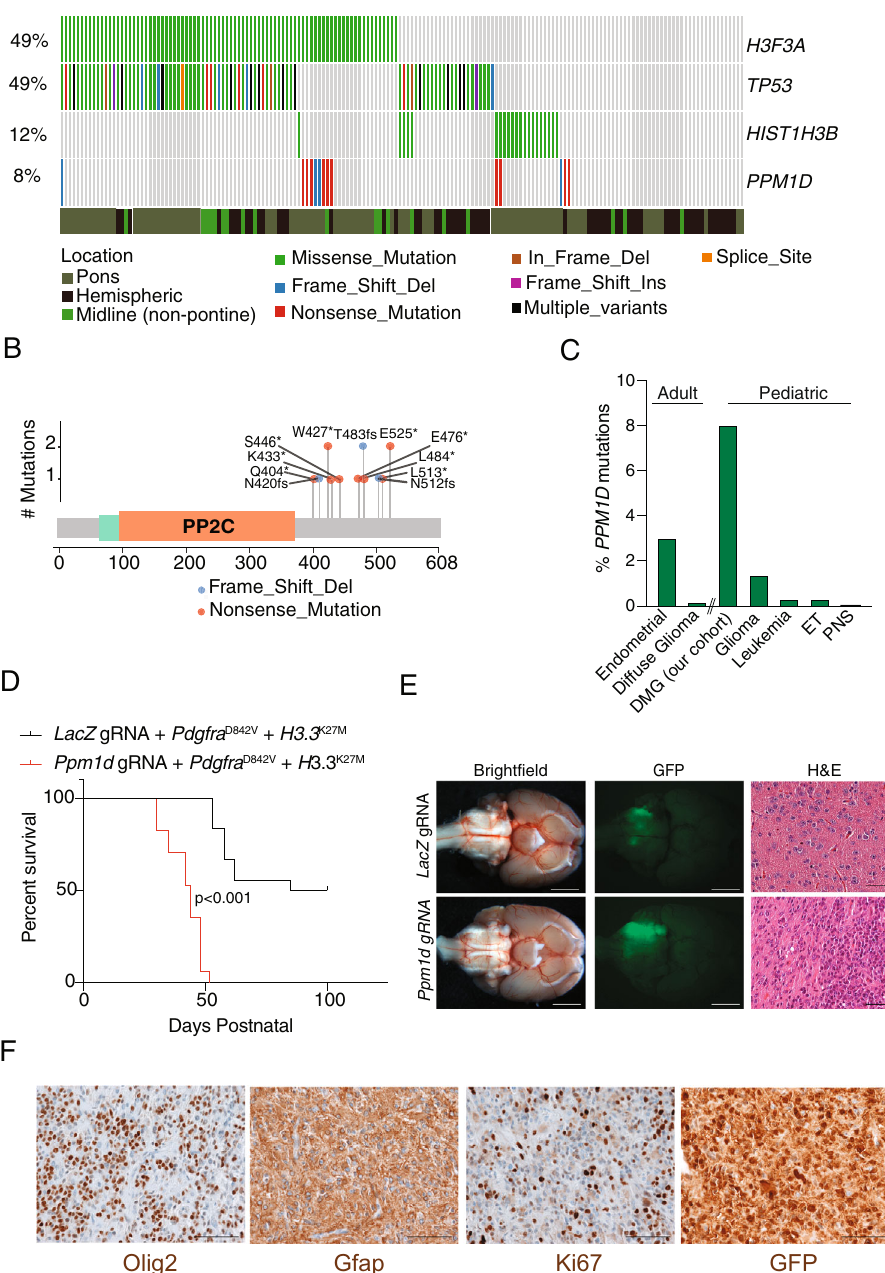
Fig. 1 PPM1D mutations are oncogenic drivers of DMGs. A Comutation plot showing alterations in histones ( H3F3A and HIST1H3B ), TP53, and PPM1D in 170 midline and non-midline gliomas. Variants observed are depicted below. B Lollipop plot of recurrent C-terminus PPM1D truncating mutations observed in DMGs. The position of nucleotide variants are shown. *Depicts nonsense or truncating alterations. C Percentage of samples with PPM1D truncating mutations across different adult and pediatric tumors including DMG dataset from our study. D Kaplan – Meier survival curves for H3.3 K27M + Pdgfra D842V IUE DMG mouse models with LacZ gRNA ( n = 18) or Ppm1d gRNA ( n = 17). P < 0.0001 between LacZ gRNA vs Ppm1d gRNA conditions calculated using log-rank Mantel – Cox test. E Bright fi eld and GFP images of LacZ and Ppm1d gRNA IUE DMGs showing GFP-positive tumor regions, and H&E-stained images depicting high-grade glioma histology. Scale bar denotes 2.5 mm (bright fi eld and GFP) and 50 μ m (H&E). Similar staining was performed in a minimum of three independent samples. F Ppm1d gRNA IUE DMG sections stained with Olig2, Gfap, Ki67, or GFP. Scale bar denotes 50 μ m. Similar staining was performed in a minimum of three independent samples. Source data are provided as a Source Data fi